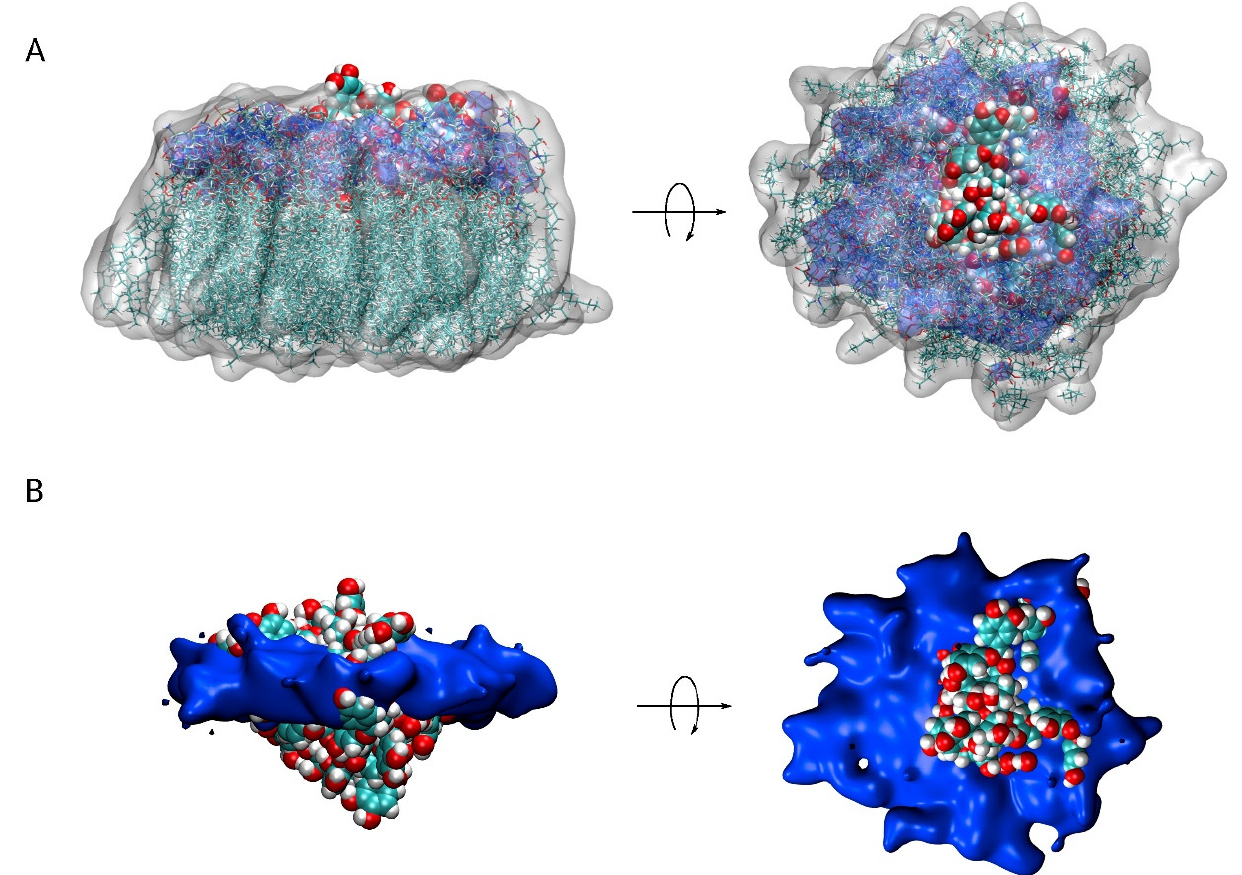
Figure 5. A view of all PC1 molecules in the monomer state together with the surrounding lipids (less than 7Å from PC1) for the five different systems (centered on PC1, 20 different superposed representations). ( A ) PC1 molecules in VDW representation, lipids in both licorice and white trans- parent surface representation and the phosphate atoms of the phospholipids in blue transparent surface representation. ( B ) PC1 molecules in VDW representation and the phosphate atoms of the phospholipids in blue opaque surface representation.